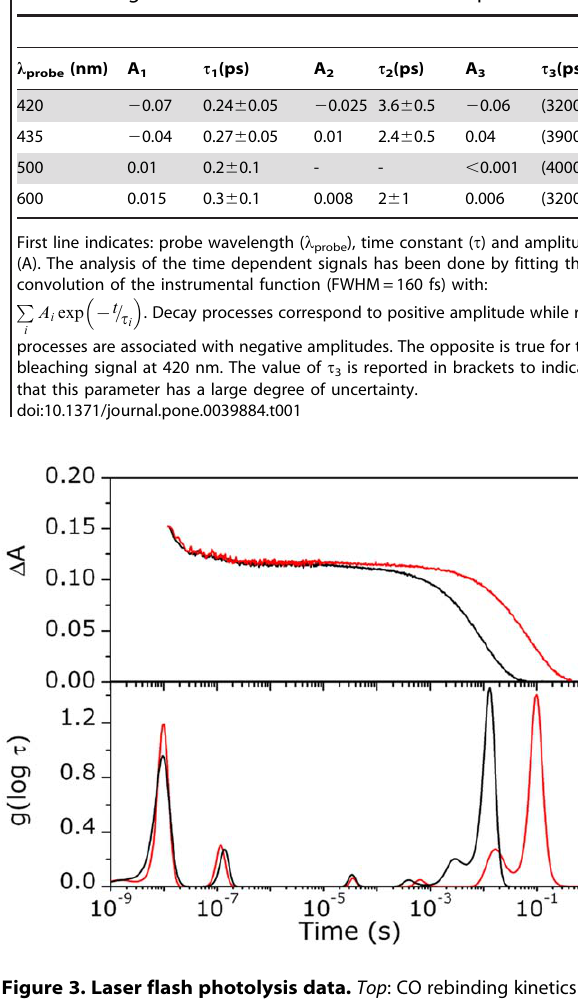
Figure 3. Laser flash photolysis data. Top : CO rebinding kinetics to Tf- trHb in solution equilibrated with 1 (black line) and 0.1 (red line) atm CO. T=20 u C; l =435 nm. Bottom : Lifetime distributions associated with the rebinding kinetics in the top panel. Protein concentration is 38 m M (2 mm path-length).